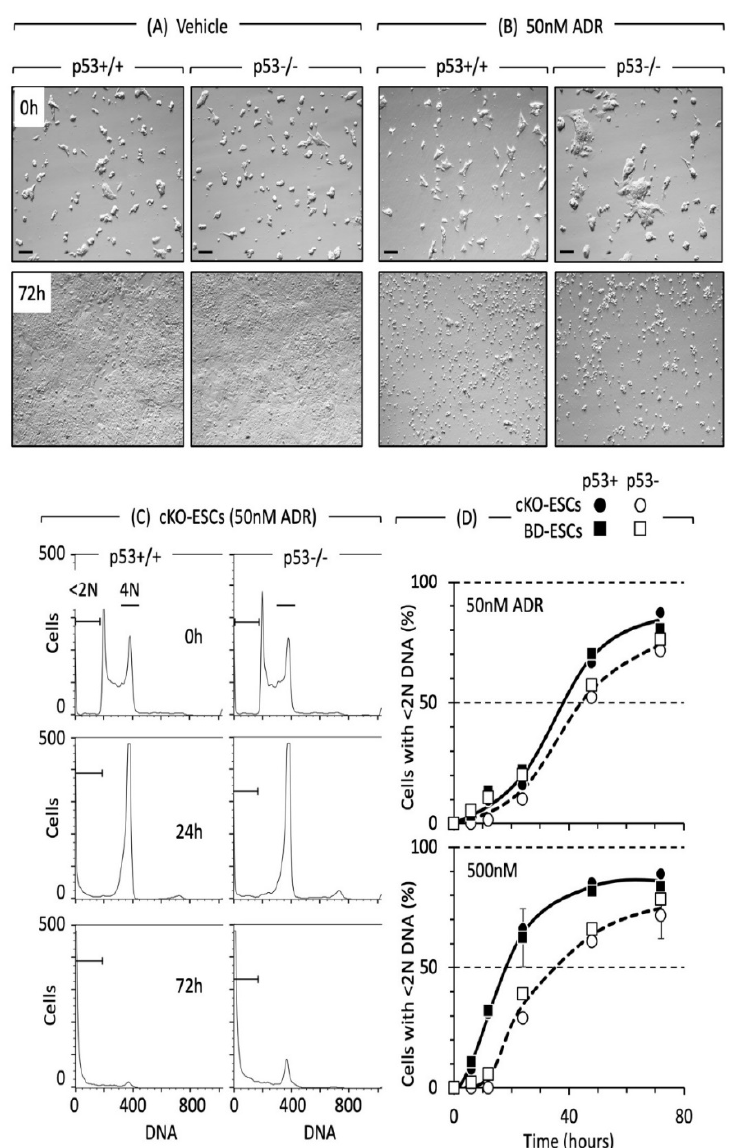
Figure 4. Cell cycle arrest and apoptosis in naïve ESCs are not dependent on p53 . Low concentrations of Adriamycin/doxorubicin (ADR) were equally toxic to both p53 +/+ and p53 -/- mouse naïve ESCs. Blastocyst derived (BD) ESCs were seeded at 14,000 cells/cm 2 and then cultured with either vehicle ( A ) or 50 nM ADR ( B ). Death was confirmed by combining attached and unattached cells and then staining with trypan blue. Results with conditional knockout (cKO) ESCs were indistinguishable from those with BD-ESCs. Figures are adapted from figures S1 (from [126]) and 1 of [126], with the permission from Stem Cells, 2020. ( C ) 50 nM ADR triggered the G2-checkpoint within 24 h and apoptosis within 72 h in both p53 +/+ and p53 -/- cKO-ESCs. Similar results were obtained with BD-ESCs. Attached and unattached cells were combined, their DNA stained with propidium iodide, and then fractionated according to DNA content using fluorescence activated cell sorting. Cells with <2N DNA content (apoptotic cells) and cells with 4N DNA content (G2/M phase cells) are indicated. ( D ) Cells with <2N DNA content were quantified as a function of time cultured with ADR. These data were normalized to 0% at zero hours. Error bars indicate ± SEM. Solid symbols are p53 +/+ cells. Open symbols are p53 -/- cells. cKO-ESCs are circles. BD-ESCs are squares. Panels C and D are examples from figures 2 and S2 in